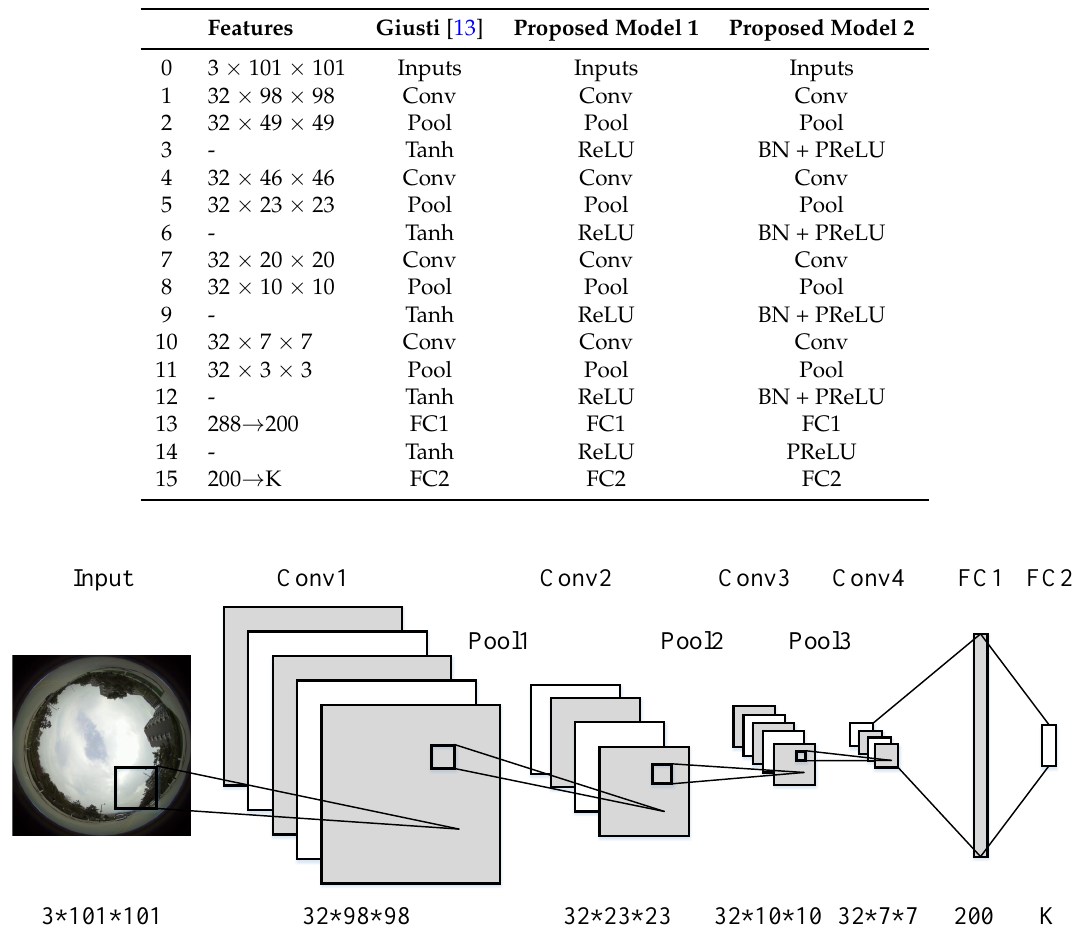
Table 1. Comparsions of network structure and layer parameters of convolutional neural networks (CNNs).